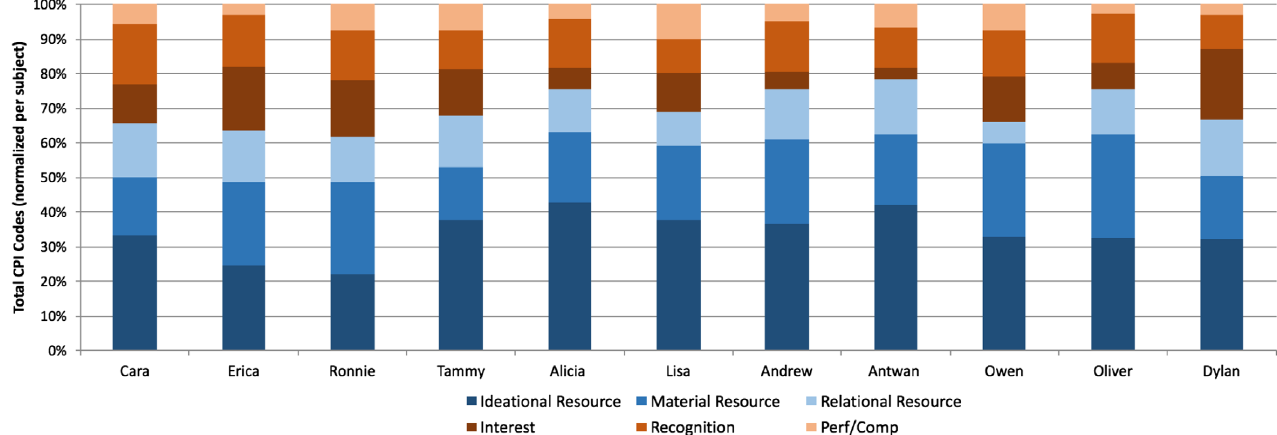
FIG. 2. CPI constructs for each participant normalized to the total code counts for each individual interview. Constructs come in two types, physics identity (orange shades) and racialized resources (blue shades). The graph shows the large difference between the percentage of physics identity constructs and the racialized identity resource constructs coded for this